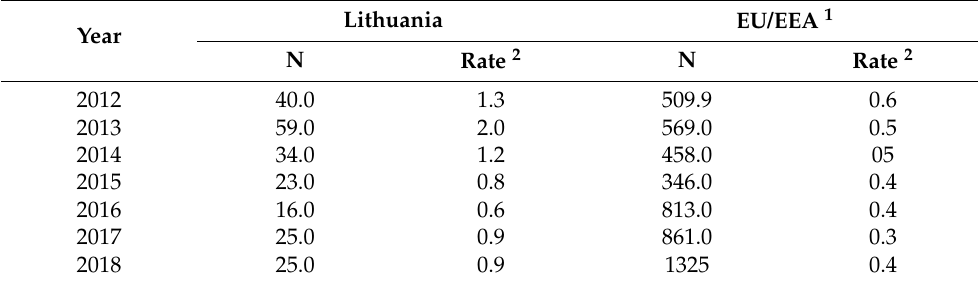
Table 2. Cases of acute HCV infection reported in Lithuania and Europe, 2012–2018. Lithuania EU/EEA 1 Year N Rate 2 N Rate 2